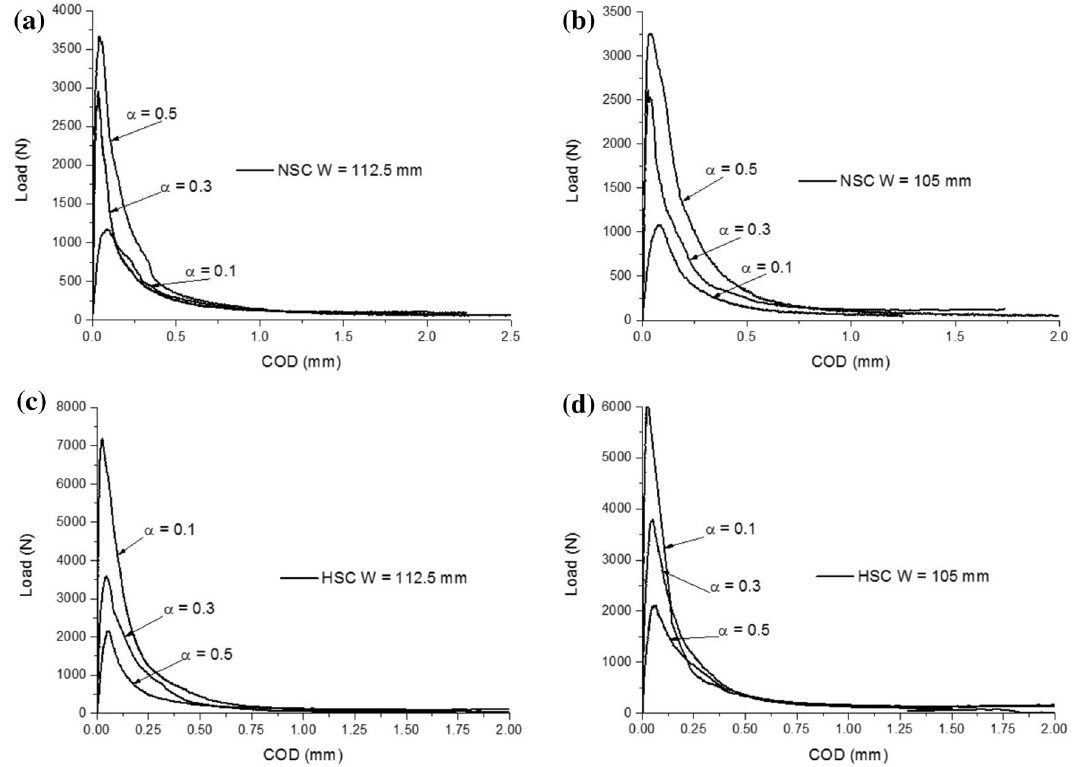
Fig. 10 Load-COD curves obtained from MDCT tests: a , b for normal-strength concrete and c , d for high-strength